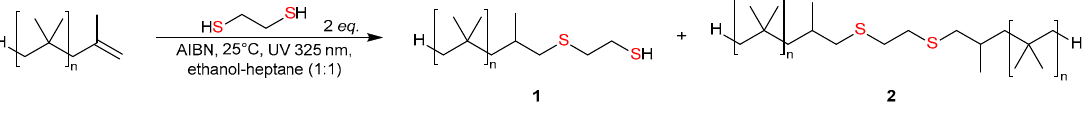
Scheme 1. Synthesis of the polymer 1 .